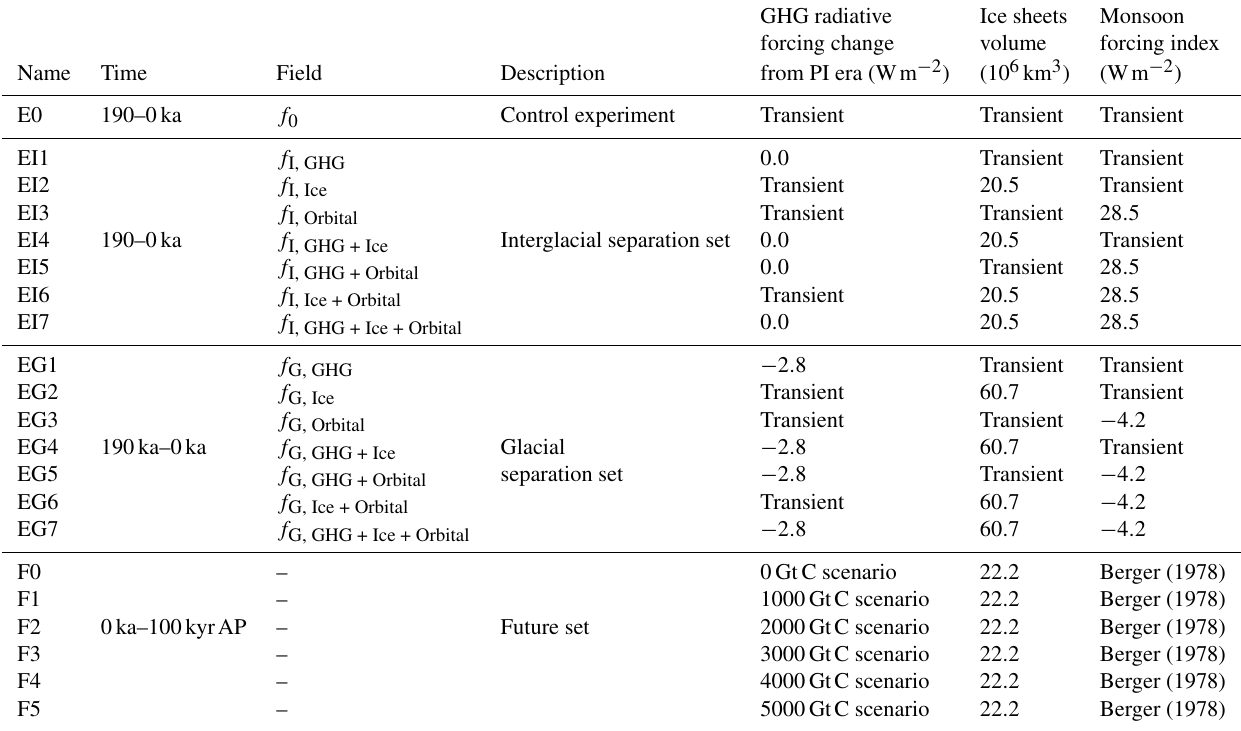
Table 1. Experiments and forcing settings. Entries in the “Field” column indicate how a climatic variable taken from an experiment is used in the factor separation method (see Appendix B with equations). Transient series are those in Fig. 1. The future set is not part of the separation method; 0ka is present day, and kyrAP is millennia after present